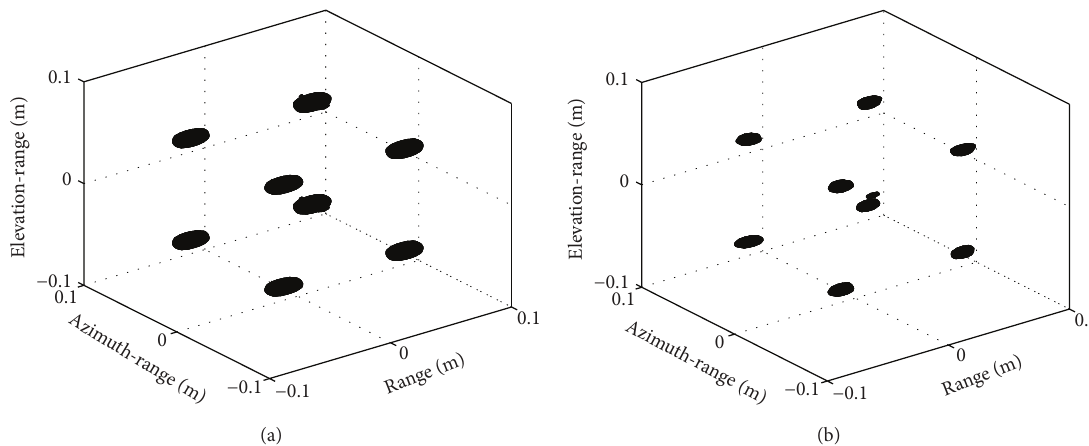
Figure 4: 3D MMW images of the target model: (a) the result of WDA using the full data and (b) the result of the CS-based method using only 25% of the full data.